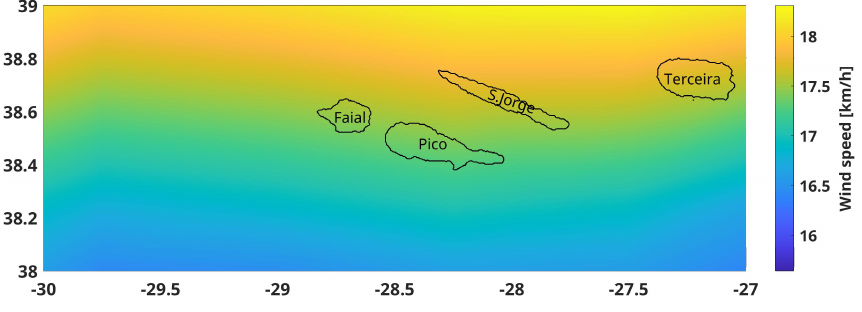
Figure 3. Azores mean wind speed for June 2018. Source: ECMFW [24]. The cumulative ship distribution drawn from AISHub 5 over the whole month of June 2018 for the study area is given in Figure 4 using logarithm base 10 of ship density evaluated in ship × hour per arc minute 2 .